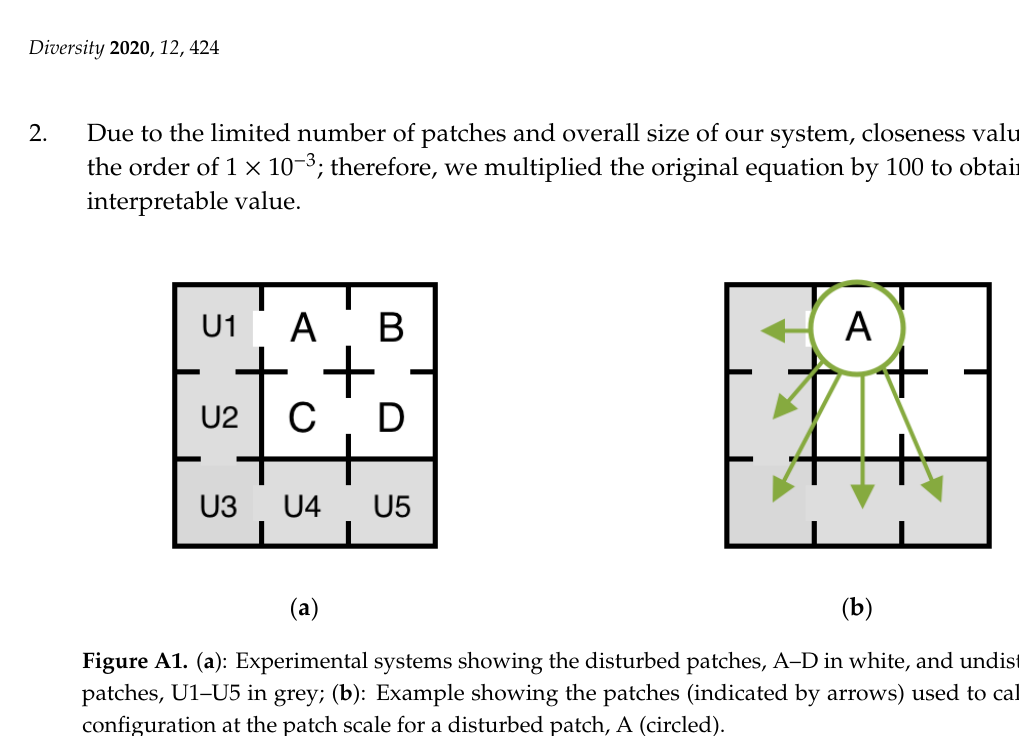
Figure A2. ( a ): Example showing the patches (indicated by arrows) used to calculate configuration for U1 (circled) (e.g., distance between U1 and all disturbed patches (in white)), with the average distance from U1 to U5 used to provide a configuration value; ( b ): Example system showing the probability in each undisturbed patch that the crab will move in the right direction toward a disturbed patch.